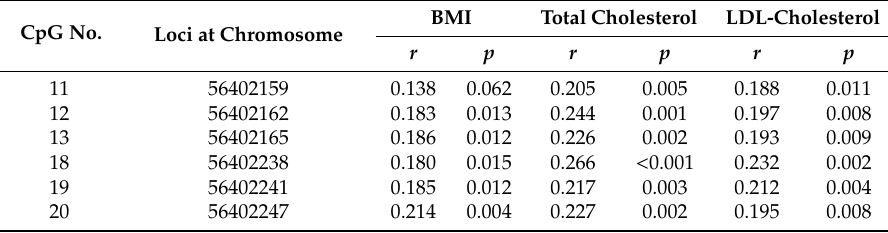
Figure 3. Analysis of the correlations between DNA methylation of the TSPOAP1-AS1 promoter region and BMI, Total cholesterol (TC), and LDL-cholesterol (LDL-C). ( A ) Total of normal and overweight / obese subjects; ( B ) Normal subjects; ( C ) Overweight / obese subjects. Table 2. Association between specific methylation of the TSPOAP1-AS1 promoter region and obesity-related markers.